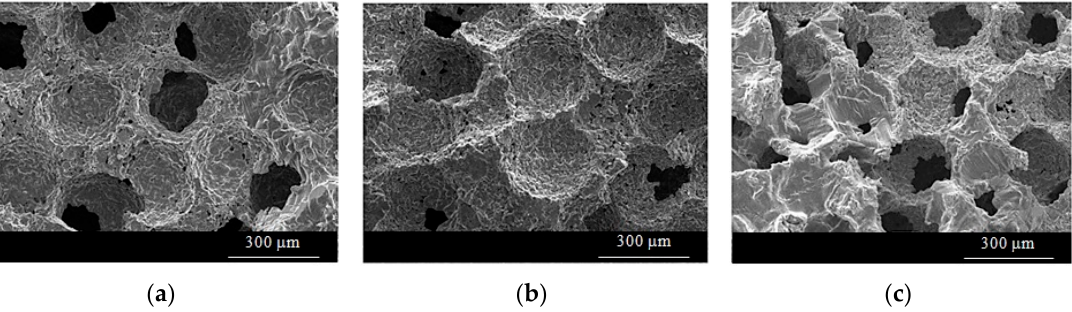
Figure 1. SEM macrostructure of porous Ti samples at ×100 magnification with porosities of ( a ) 55.9%, ( b ) 68.4%, and ( c ) 78%.